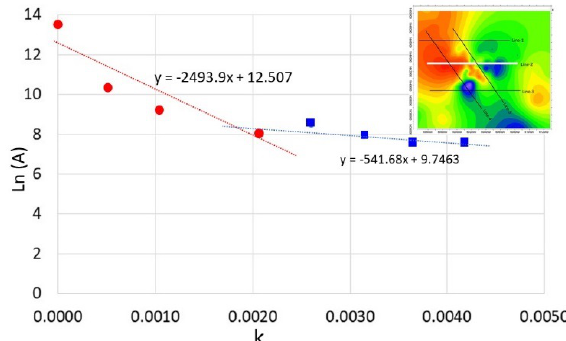
Fig. 7. Bouguer anomaly spectrum analysis to determine the depth limits of regional and residual anomalies. The spectrum analysis results for line 2 get the depth limit value of the residual regional Bouguer anomaly of 2483.9 = 2500 m.